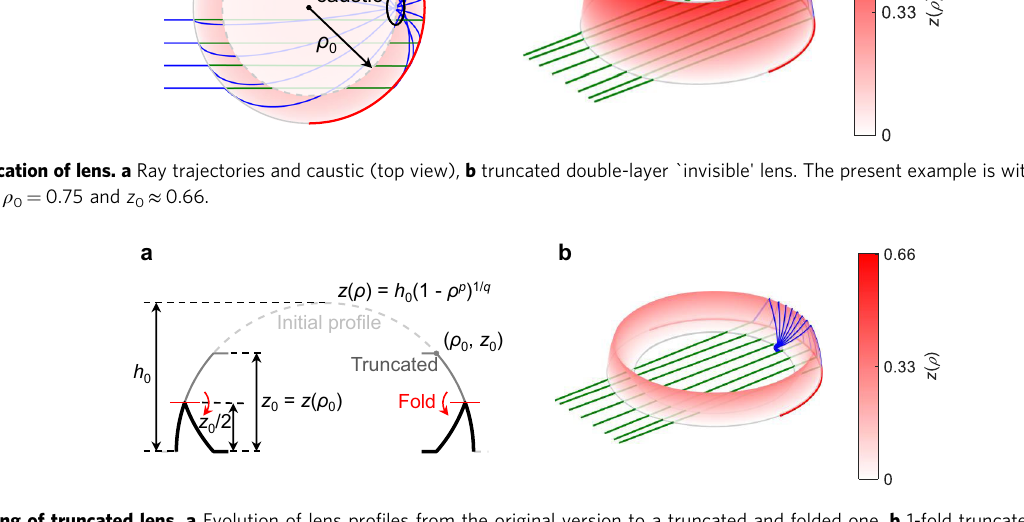
Fig. 6 Folding of truncated lens. a Evolution of lens pro fi les from the original version to a truncated and folded one, b 1-fold truncated double-layer `invisible' lens. The present example is with the dimensional parameters h 0 = 1, p = q = 2, ρ 0 = 0.75, and fi nal pro fi le height z 0 /2 ≈